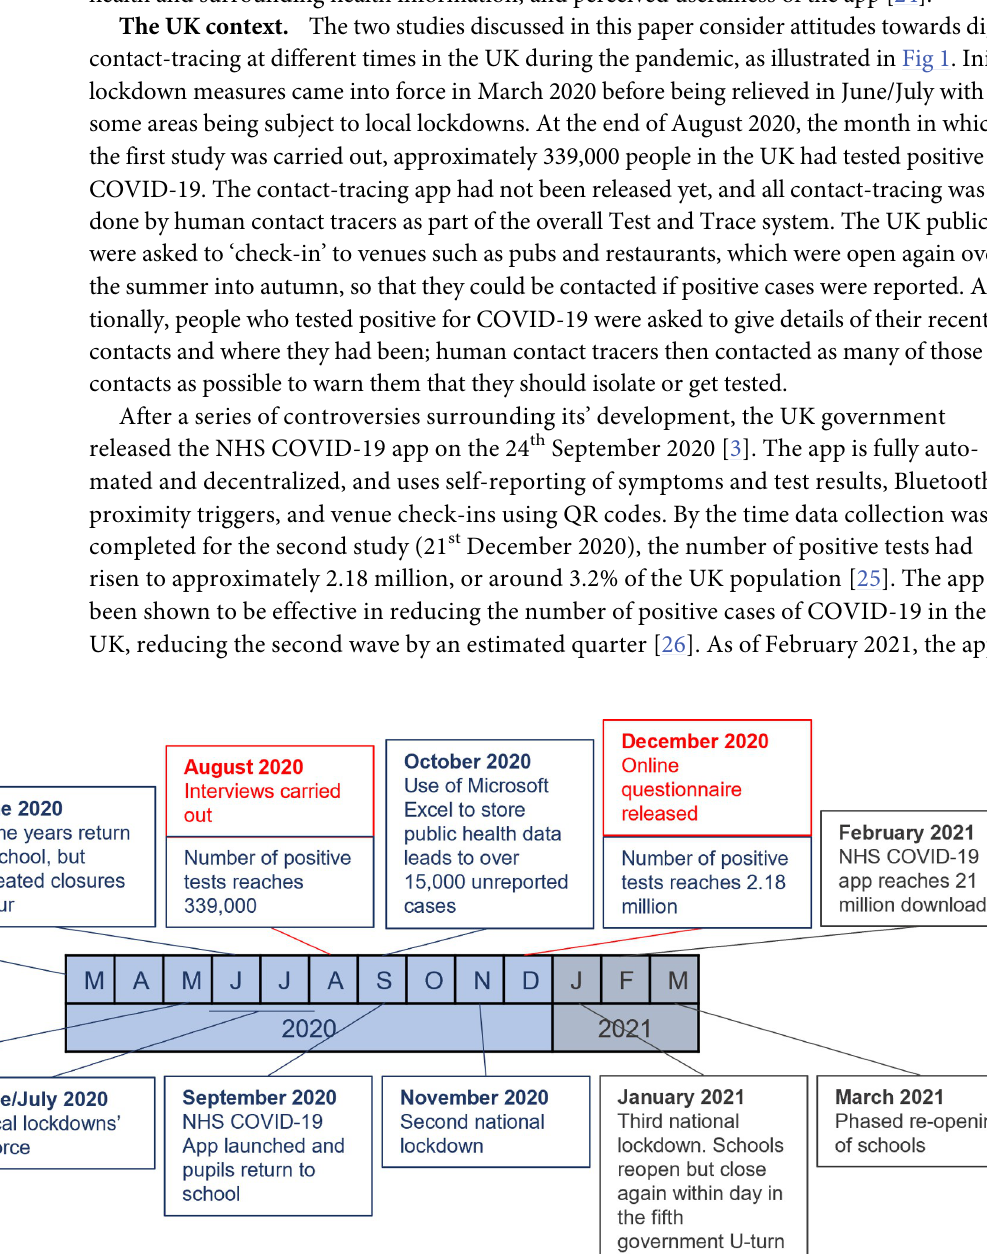
PLOS ONE | https://doi.org/10.1371/journal.pone.0276661 October 27,